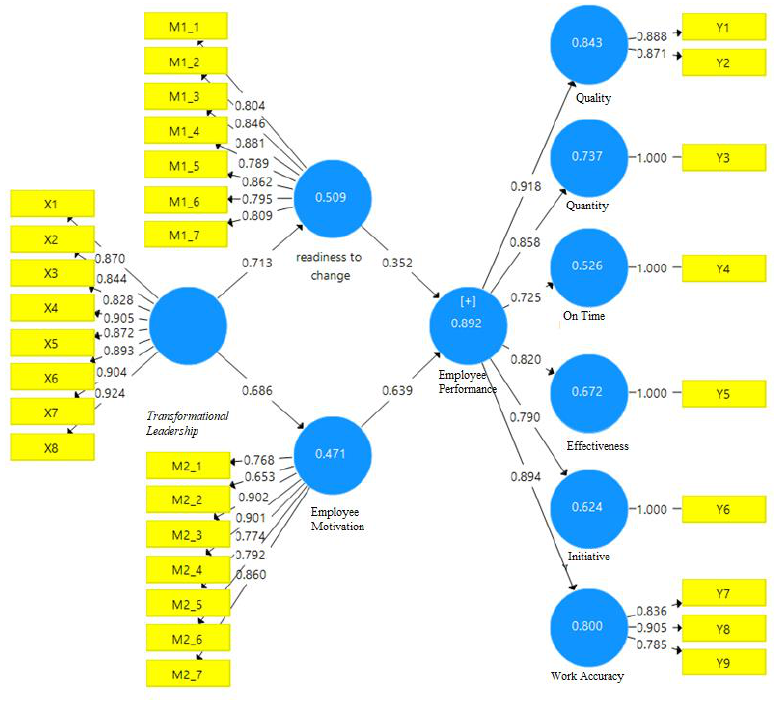
Figure 1: PLS Outer Model